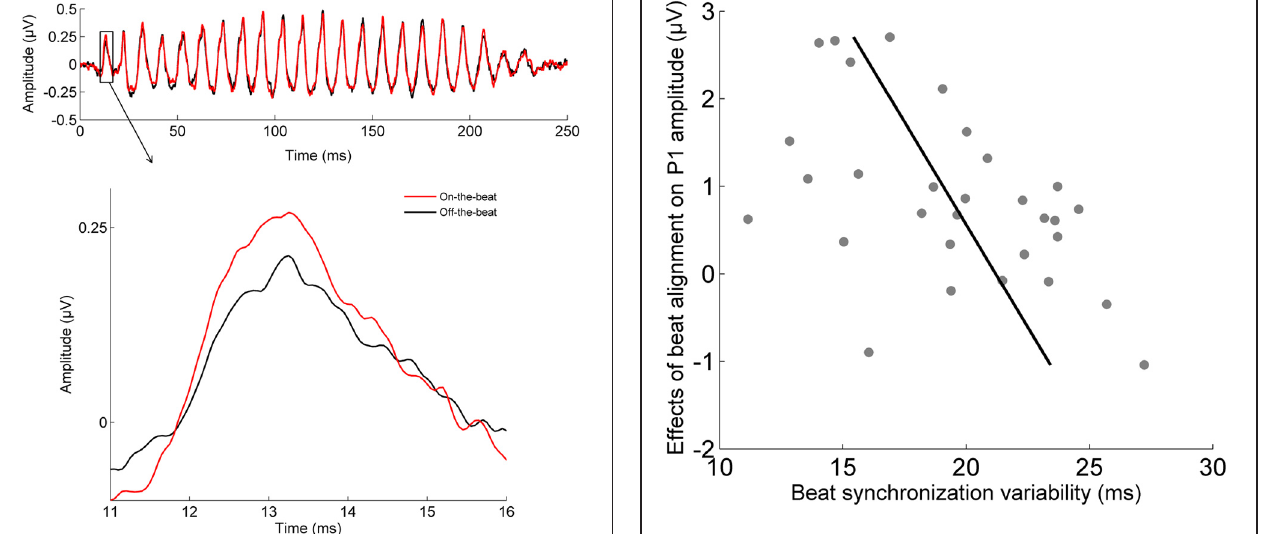
harmonics, t = 0 . 74, p > 0 . 1). The size of the cortical and brain- two conditions) did not correlate ( r = 0 . 0079, p > 0 . 1), suggest-